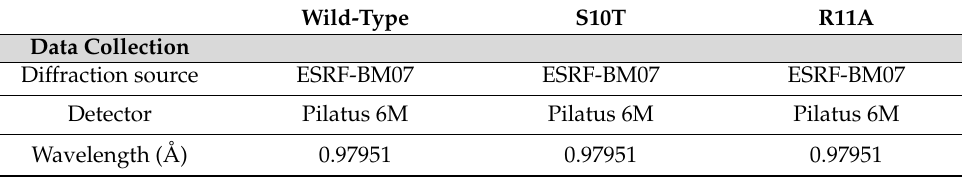
Table 1. Statistics of X-ray diffraction data collection and model